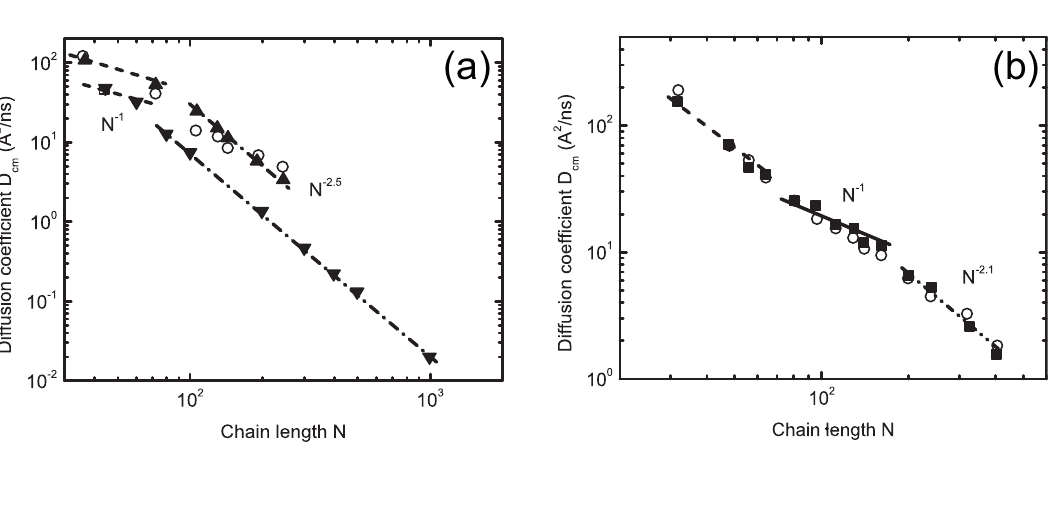
Figure 16. Center of mass self-diffusion coefficient, D ( b ) cis-1,4-PB polymer melts. In ( a ), the downward and upward triangles denote 400 K and 509 K,